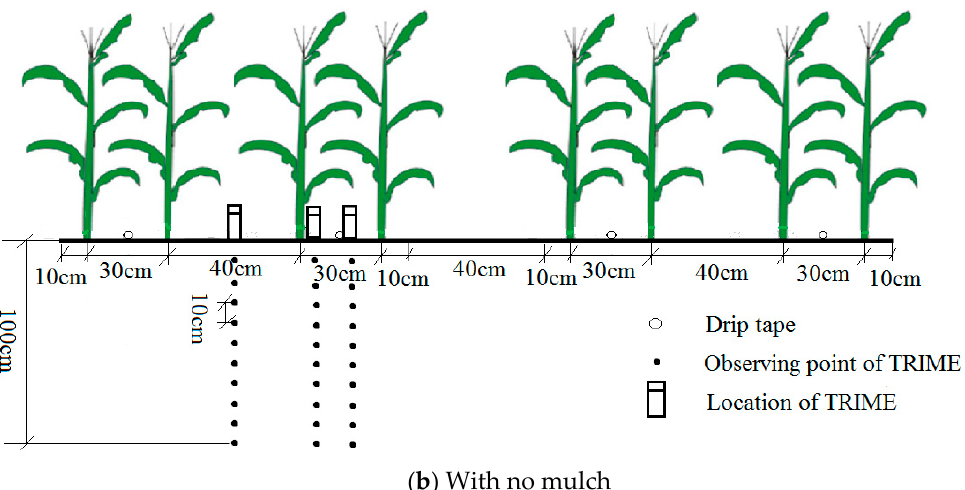
Figure 1. Plot design for estimating evapotranspiration of drip-irrigated summer maize in Xinjiang, China. ( a ) With partial mulch; ( b ) With no mulch. (TRIME was the TRIME TDR system to determine the soil volumetric water content).